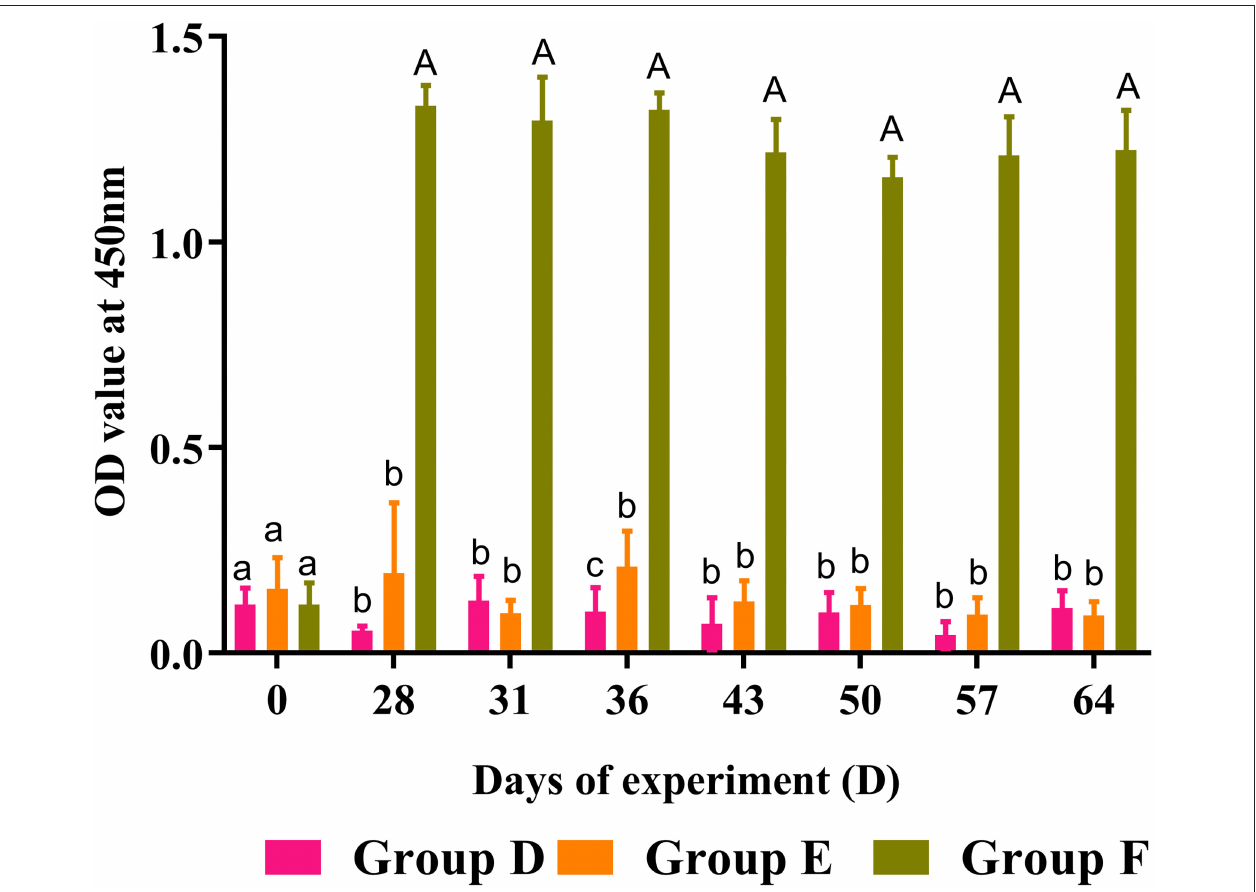
FIGURE 7 | Dynamics of rHc8-specific IgG in sera of trial 2. Group D, unchallenged goats; Group E, goats challenged with L3s; Group F, goats vaccinated by rHc8 antigen mixed with Freund’s adjuvants (at day 0 and 15), and challenged with L3s (at day 29). Data are presented as mean ± SEM. Same letter indicates nonsignificant difference ( p > 0.05). The different lowercase letters indicate significantly different values at p < 0.05. Different between uppercase and lowercase letters indicate significantly different values p <